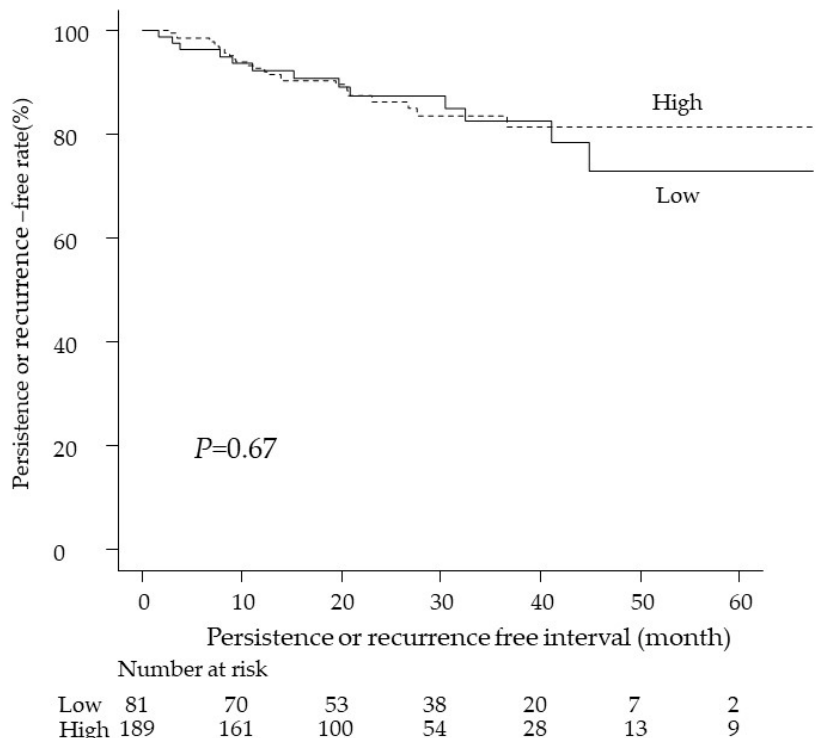
Figure 1. Kaplan–Meier time-to-persistence or recurrence curves based on surgeon volume. The dotted line represents the persistence or recurrence curve of women treated by low-volume surgeons, while the solid line represents the curve of women treated by high-volume surgeons. The Cox proportional hazard regression model was used to determine the p -value.